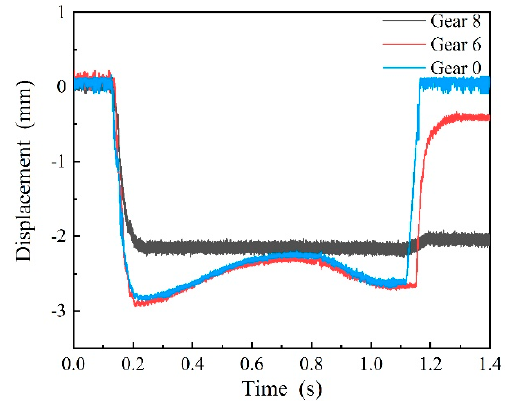
Figure 12. The motion process of the measuring ruler at different hydraulic damper gears on site.